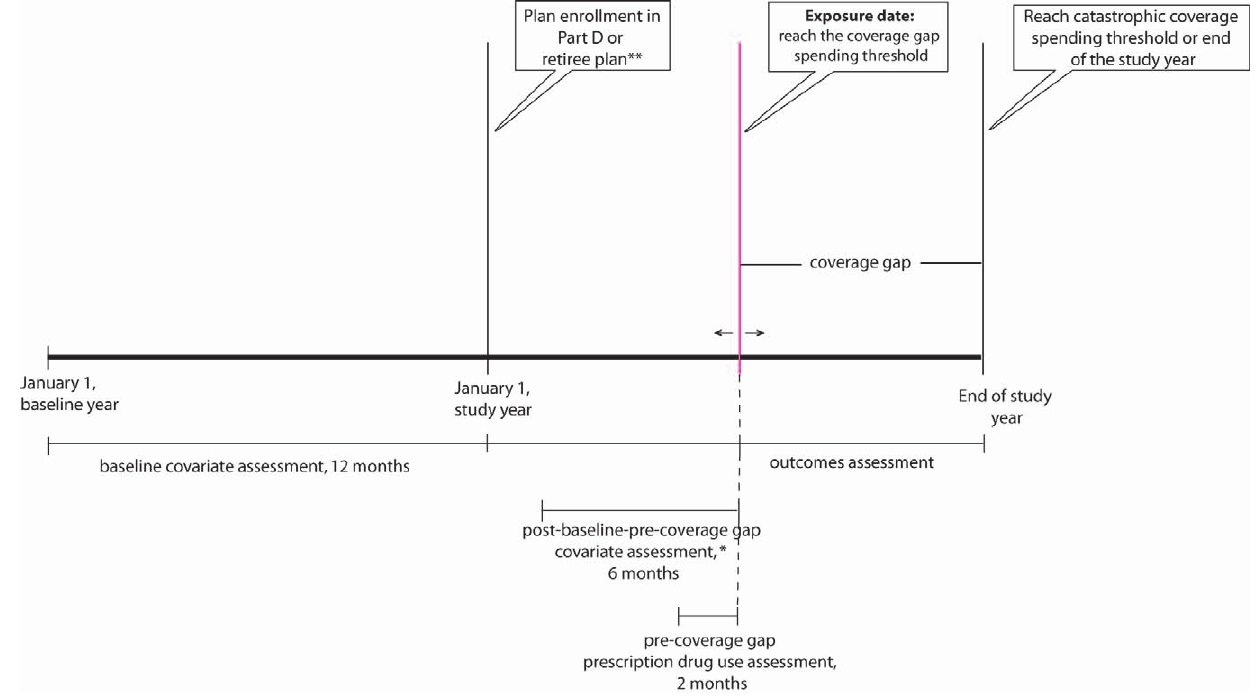
Figure 1. Prospective open cohort study design.